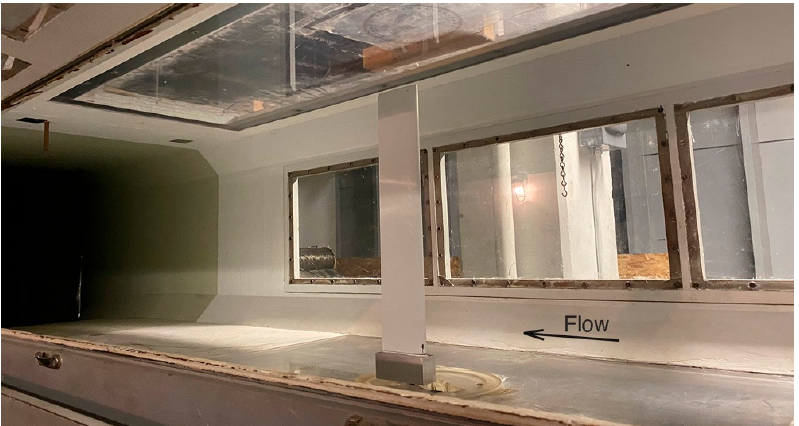
Figure 12. DAP wing mounted in the 21 × 30 ″ (53.3 × 76.2 cm) wind tunnel at the University of Kansas (USA) Aerospace Engineering Department.